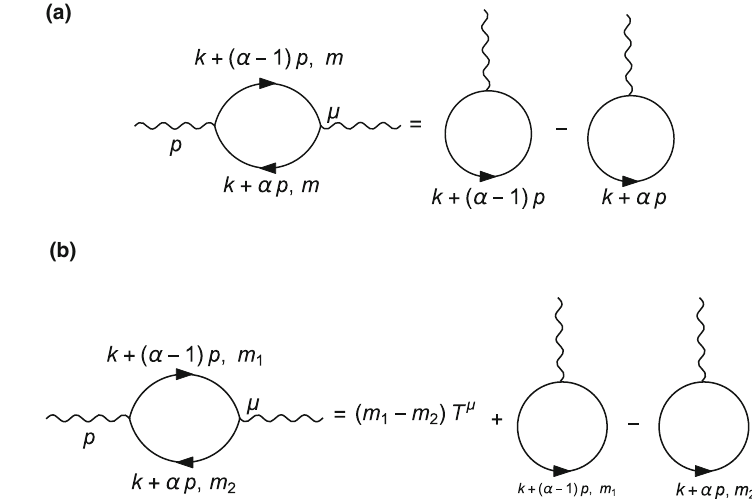
Fig. 2 a Diagrammatic representation of the gauge and momentum routing invariance relation for QED. b The same diagrammatic representation for fermions with different